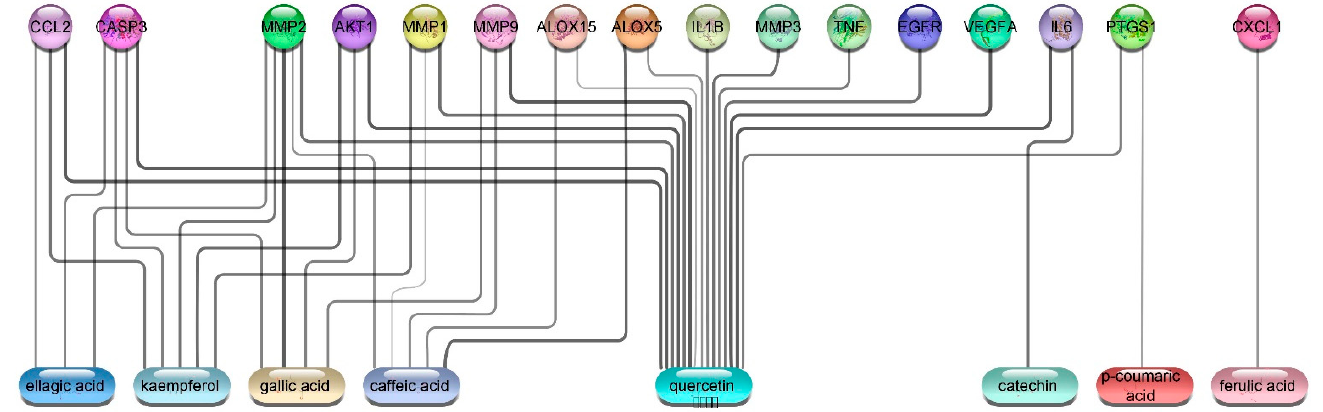
Figure 20. Compound–target network of eight isolated compounds with the potential target proteins, the edges represent a weighted compound–protein connection as the thickness of the edge related to the degree of connectivity, this figure were suggested from the STRING database.